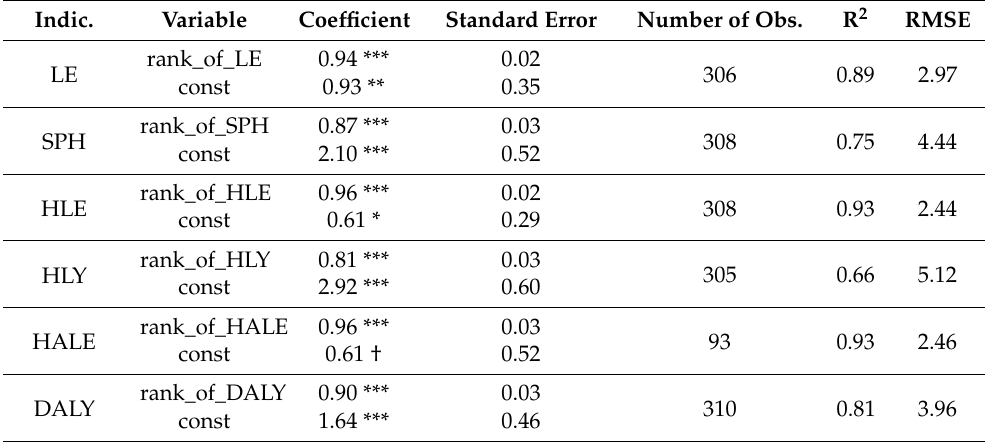
Table 10. Regression models of the dependence of the indicator ranks for the older subpopulation on the indicator ranks for the total population 2010–2019.